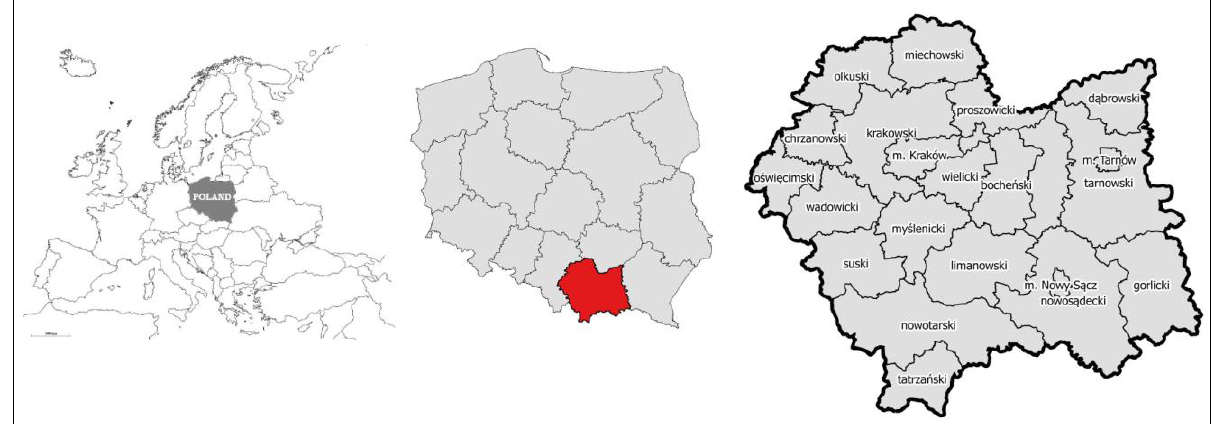
Fig. 1. Location of the Małopolskie voivodeship – study area (source: own